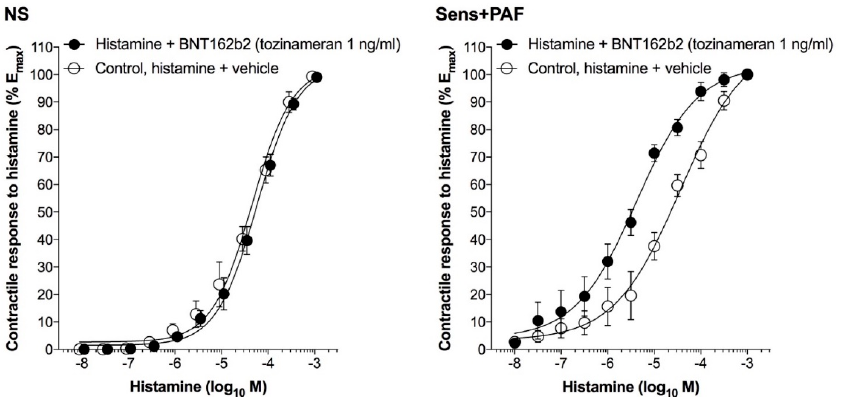
Figure 3. Effect of BNT162b2 on the CRCs to histamine in NS and sens+PAF isolated airways. Results reported as mean ± SE of n = 5 human isolated sub-segmental bronchi. CRC: concentration- response curve; NS: non-sensitized; PAF: platelet-activating factor; sens+PAF: passively sensitized plus PAF challenge.